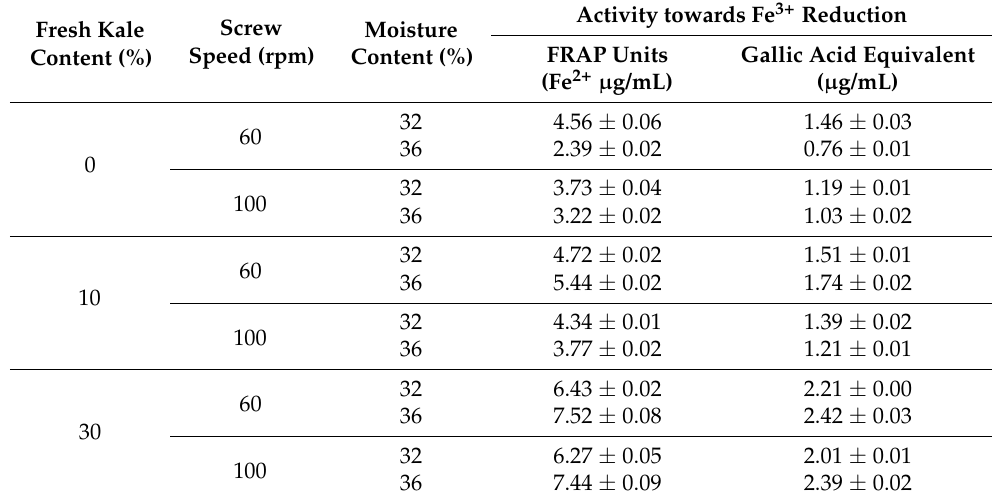
Table 2. Parameter values describing extract antioxidant properties (n = 3, ± SD).